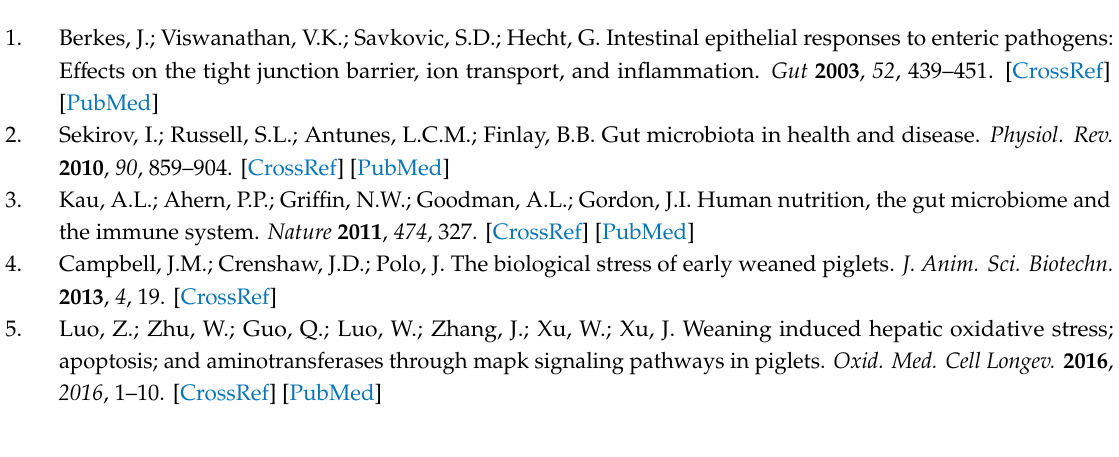
Supplementary Materials: The following are available online at http: // www.mdpi.com / 2076-2607 / 8 / 3 / 391 / s1, Table S1: Ingredients composition and nutrient levels of basal diets (as-fed basis); Table S2: E ff ects of dietary exogenous catalase supplementation on the relative abundance of colonic microbiota at the genus level; Table S3: E ff ects of dietary exogenous catalase supplementation on the colonic microbiota functions. Author Contributions: Conceptualization, Y.L., X.Z. (Xilun Zhao), and D.W.; Data curation, Y.L. (Yang Li),